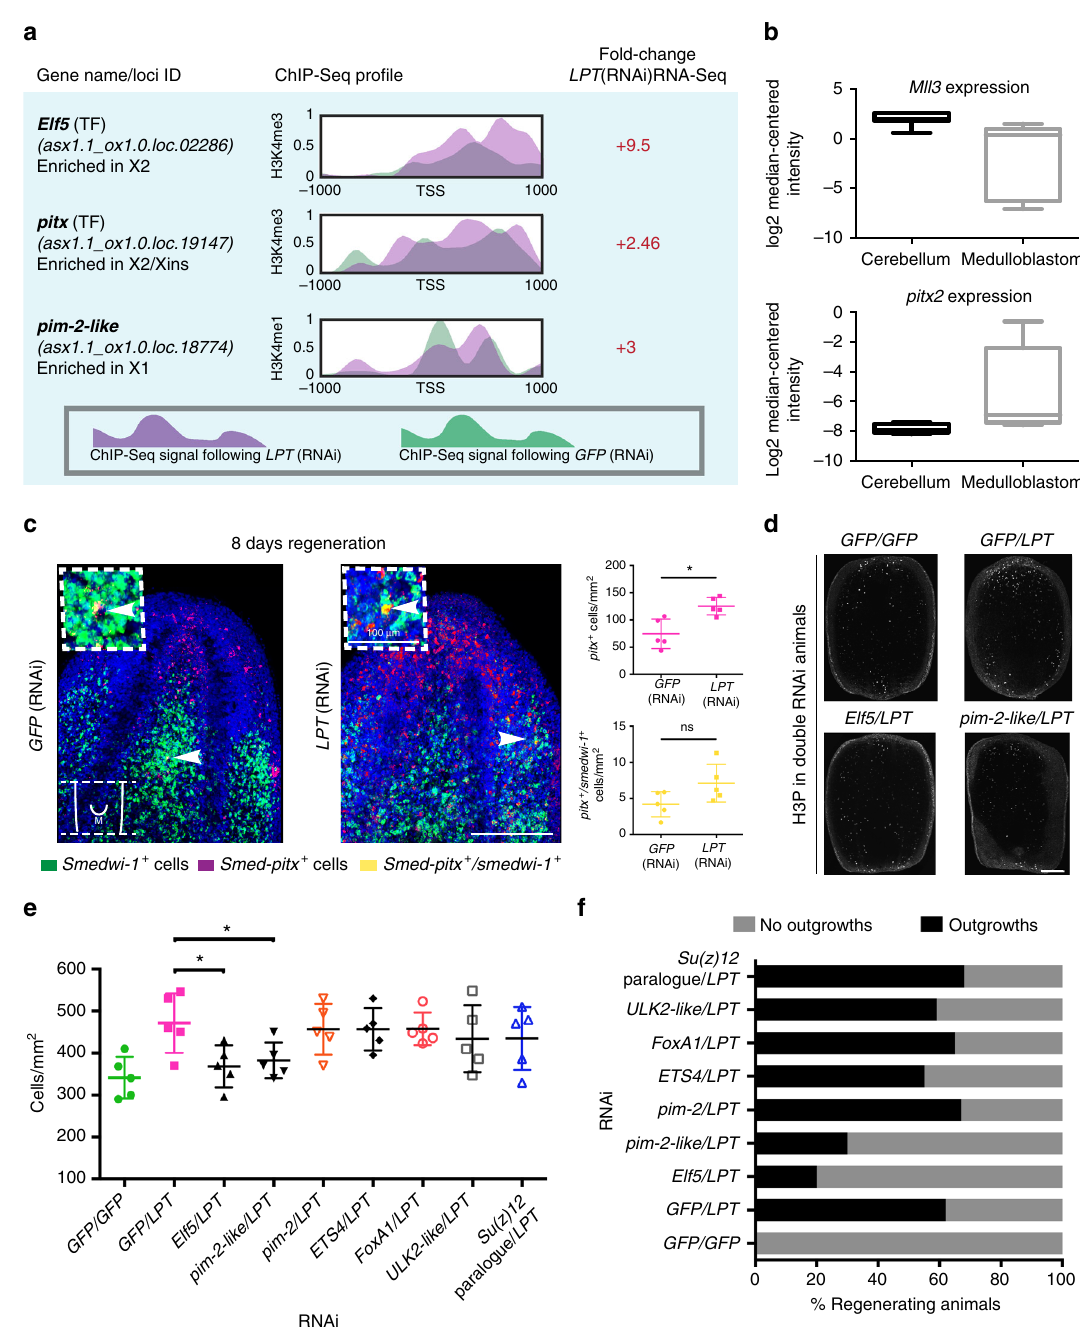
Fig. 9 Double knockdown with Elf5 or pim-2-like alleviates the LPT (RNAi) over-proliferation and outgrowth phenotype. a Examples of genes signi fi cantly ( p < 0.05) up-regulated in G2/M stem cells following LPT (RNAi). The ChIP-seq pro fi le for H3K4me3 or H3K4me1 in the 2 kb region around the TSS of each gene is presented. Purple color represents normalized signal following LPT (RNAi) and green color is used to show the normalized signal following GFP (RNAi). The bold font of the gene names signi fi es a correlation between the genes ’ up-regulation and their respective H3K4me3/me1 pro fi le. ‘ TF ’ stands for ‘ transcription factor ’ . All three genes show correlation between ChIP-seq pro fi le and up-regulation in RNA-seq data. b in silico analysis (www.oncomine. org; t -test, p < 0.0001) of Mll3 and pitx2 expression in normal tissue (cerebellum) and cancer tissue (medulloblastoma). Lines and error bars indicate mean and SD. c pitx and smedwi-1 in situ hybridization at 8 days of regeneration of middle pieces following LPT (RNAi). White arrows show double-positive cells. Lines and error bars indicate mean and SD. Two-tailed t -test used for analysis ( n = 5), * p < 0.05, ns is not signi fi cant. d Representative examples of mitotic cells (labeled by anti-H3P antibody) in double RNAi condition at 48 h post amputation. e Graph showing number of mitotic cells in double RNAi animals at 48 h post amputation. Each dot represents average number of mitotic cells in single worm ( n = 5). Lines and error bars indicate mean and SD. Two-tailed t test: * p < 0.05. f Graph showing percentage quanti fi cation of double knockdown regenerates developing outgrowths. Scale bars: 200 μ